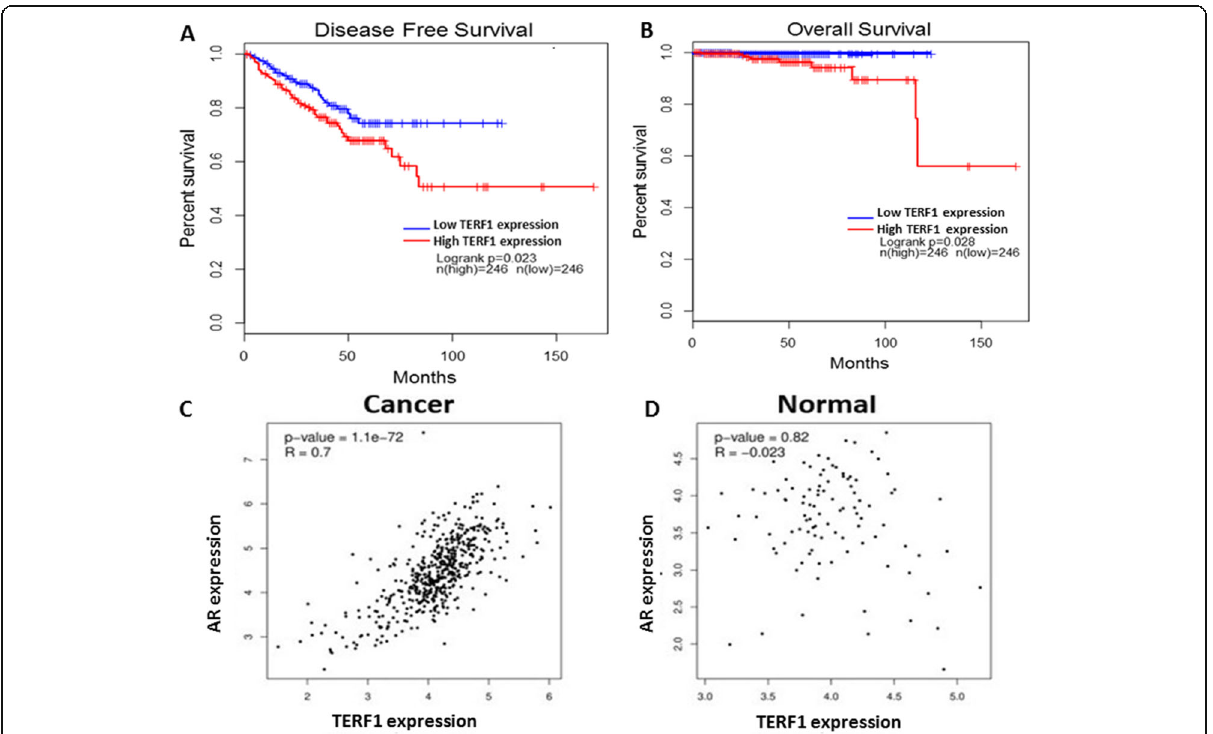
Fig. 4 Association between TERF1 gene expression with prognosis. A Kaplan – Meier disease-free survival plot. B Kaplan – Meier overall survival plot. C Correlation of AR expression with TERF1 in cancer. D Correlation of AR expression with TERF1 in normal